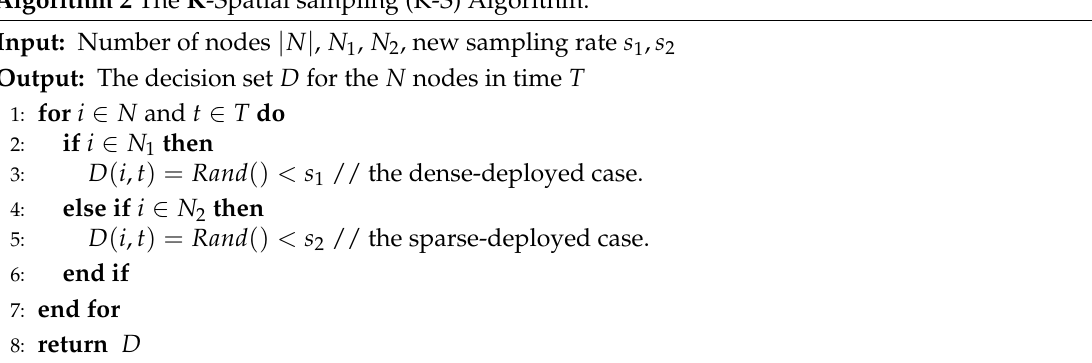
Algorithm 2 The K -Spatial sampling (K-S)